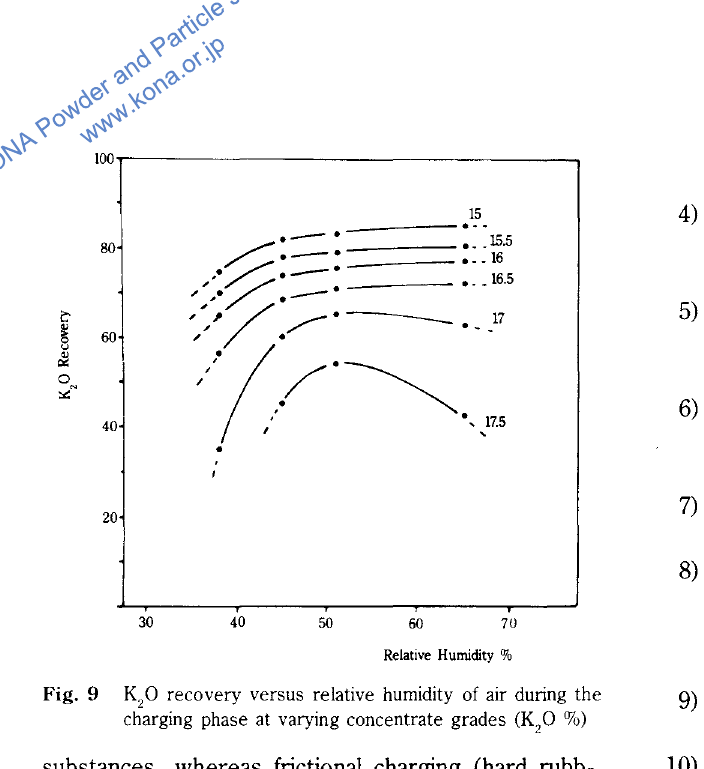
K 0 recovery versus relative humidity of air during the 2 charging phase at varying concentrate grades (K substances, whereas frictional charging (hard rubb ing) is due to substantially different mechanisms such as material transfer and hot-spot